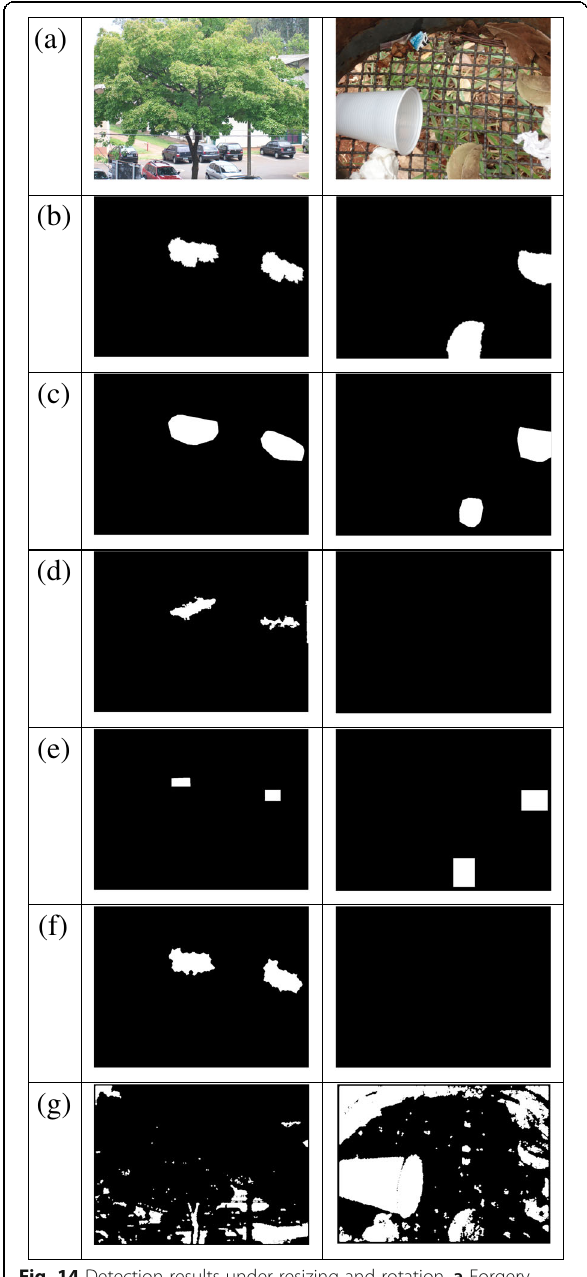
Fig. 14 Detection results under resizing and rotation. a Forgery images. b Ground truth. c Our proposed. d Amerini et al. [13]. e Silva et al. [16]. f Pun et al. [18]. g Li et al. [19]